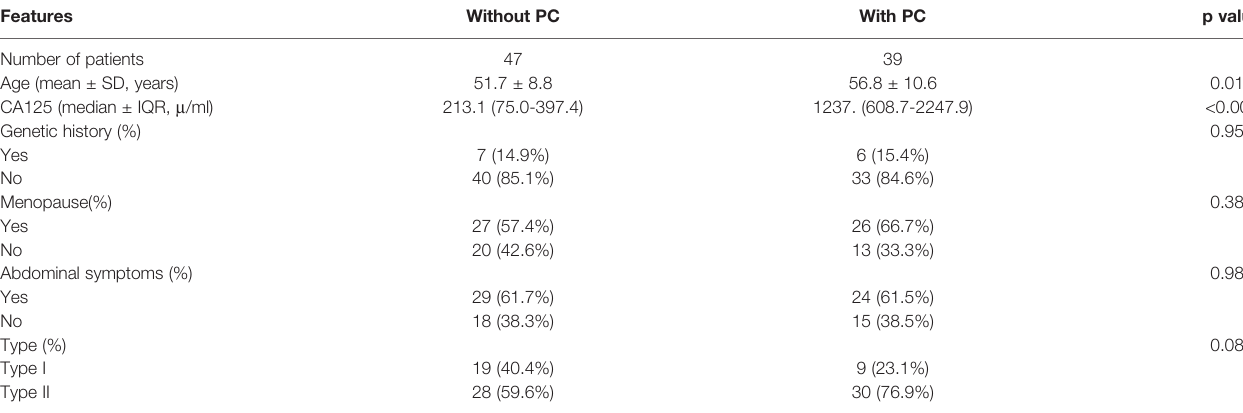
TABLE 1 | Single-factor analysis of clinicopathological characteristics of 86 EOC patients. Features